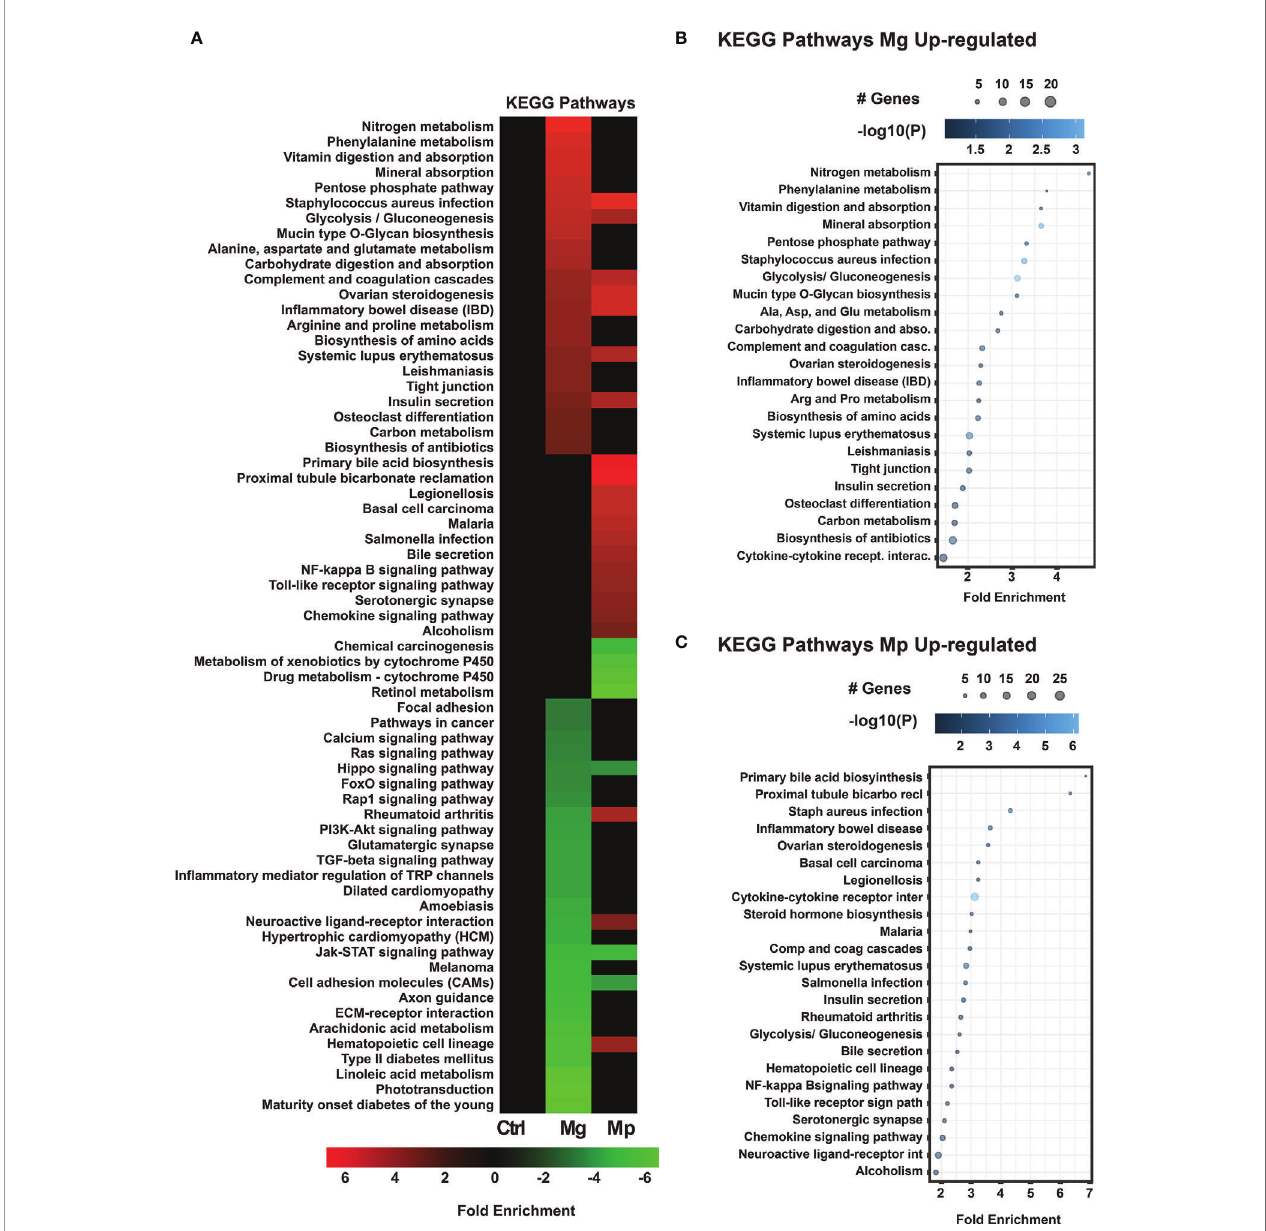
FIGURE 2 | KEGG Pathways enrichment analysis for M. genitalium (Mg) and M. pneumoniae (Mp) regulated genes. (A) KEGG pathways heat map showing fold enrichment contrast between Mg and Mp. (B) Dot blot for Mg up-regulated genes, (C) Dot blot for Mp up-regulated genes. Dot blots measure fold enrichment of the pathways, dot size represents total number of genes included in each category, and gradient color shows statistical signi fi cance [-log 10 ( P